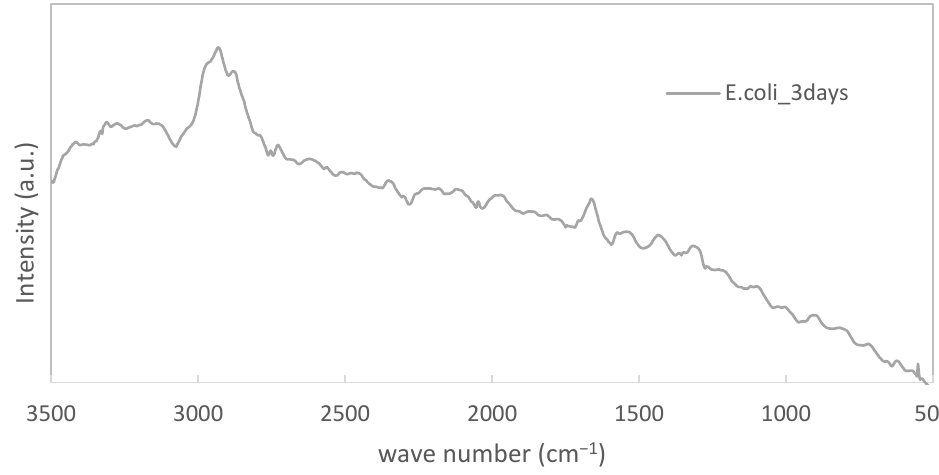
Figure 3. Raman shifts of PE specimens with immersion time.